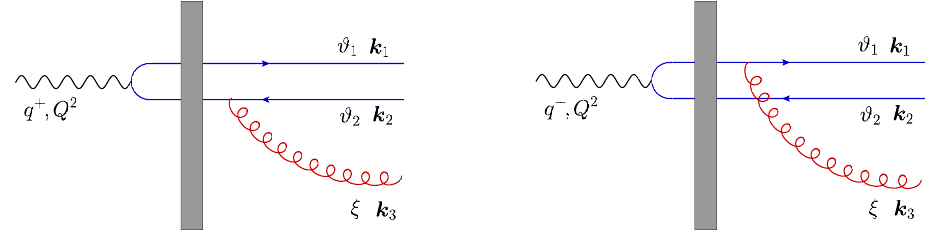
Figure 4 . The same as in figure 3, but for the case where the gluon is emitted after the